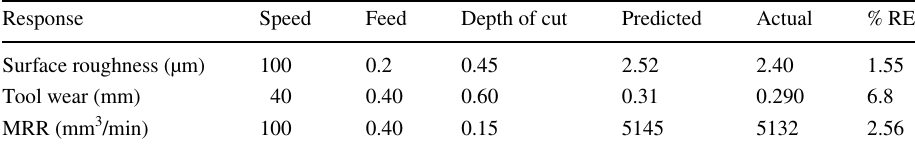
Table 17 Optimization by